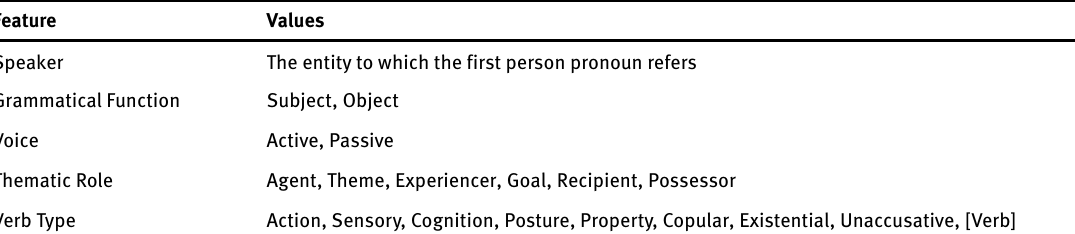
Table 1: Overview of coded features associated with first-person pronouns Feature Values